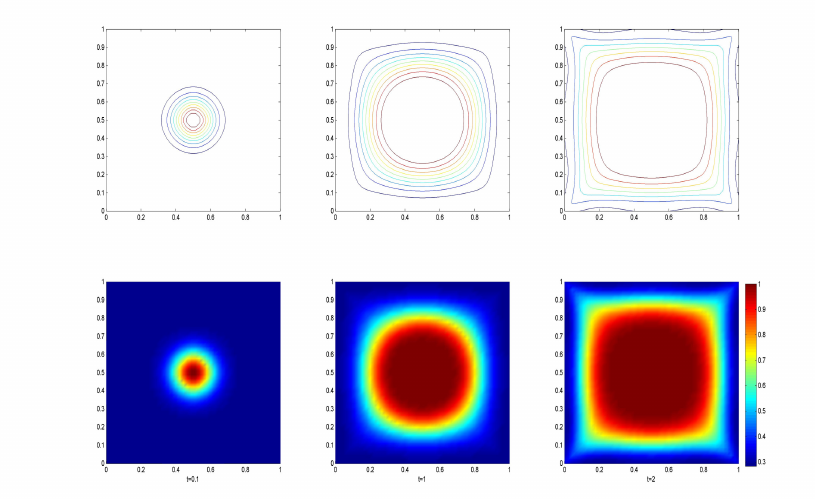
Figure 4. Contours and graphs of concentration in five-spot